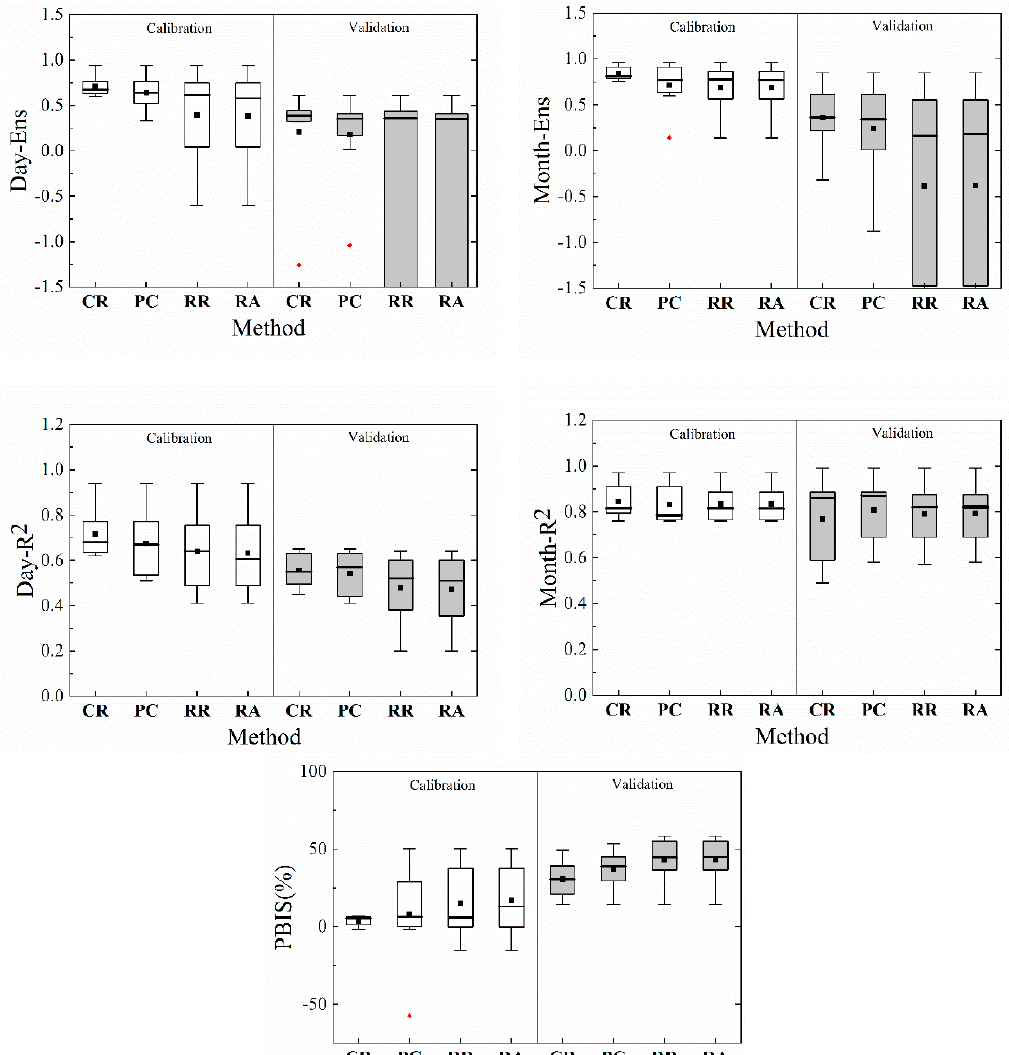
Figure 2. The distribution of the model performances for the calibrated and validated PT method in the eight catchments. The central line on each boxplot is the median, the edges are the 25th and 75th percentiles, and the red plots are outliers.